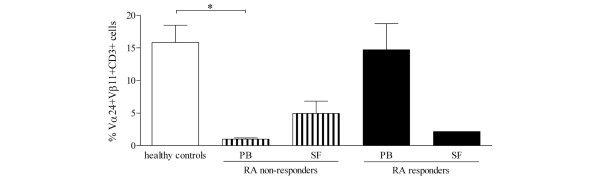
Rheumatoid arthritis (RA) patients can be divided into responder and nonresponder patients, based on peripheral blood derived natural killer T (NKT) cell reactivity to α-galactosylceramide (α-GalCer). Peripheral blood (PB) mononuclear cells (1.5 × 106 cells/well) from nine healthy control individuals and 13 RA patients, as well as synovial fluid (SF) mononuclear cells from five RA patients, were stimulated with α-GalCer and re-stimulated on day 7 with autologous, α-GalCer pulsed, irradiated PB mononuclear cells in the presence of 2 U/ml IL-2. NKT cell numbers were determined by flow cytometry on day 14. Patients were considered nonresponders when the frequency of Vα24+Vβ11+CD3+ NKT cells derived from PB mononuclear cells was lower than 2% after 14 days of culture. Error bars indicate standard error of the mean. *P < 0.01.